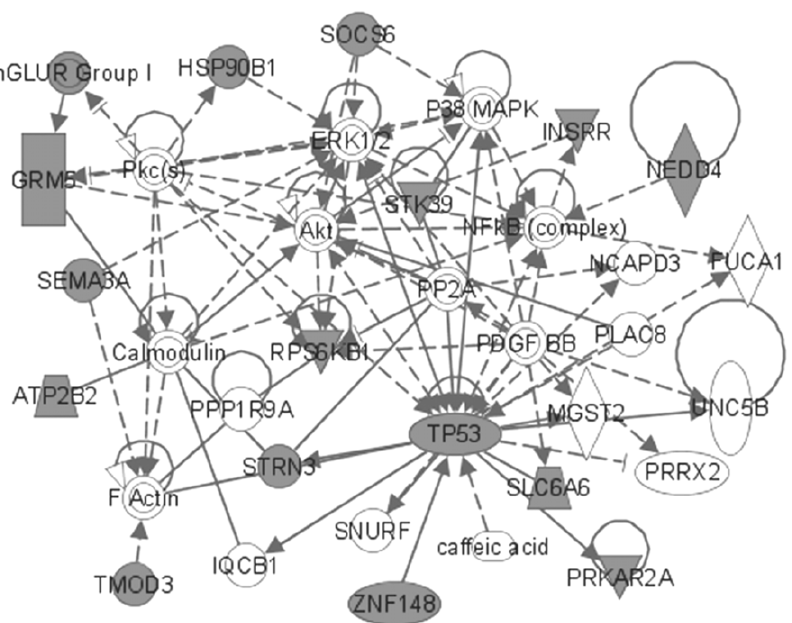
Figure 6. MAM-modulated brain gene products (anchored) for Mgmt 2 / 2 vs. wild type. Most significant MAM-modulated expression sub- network in the brain of Mgmt 2 / 2 vs. wild type mice (all time-points combined) composed of 60 differentially expressed genes that were anchored to O 6 -mG levels. Note the presence of NF- k B, ERK1, and p38-MAPK hubs, and the involvement of TP53 and glutamate receptors.